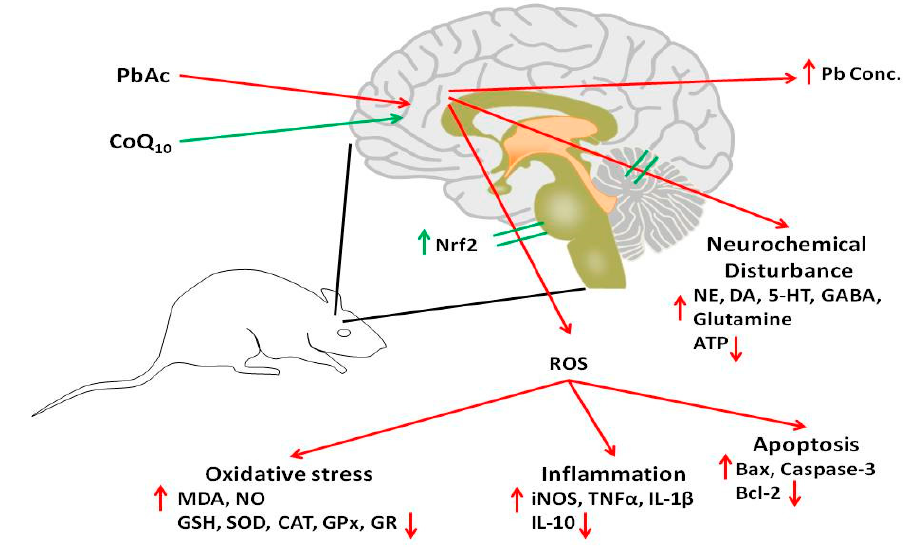
Figure 8. A summarized figure describes the potential protective role of CoQ10 against lead acetate-induced neurotoxicity; CoQ10: coenzyme Q10; PbAc: lead acetate; Nrf2: nuclear factor erythroid 2–related factor 2; ROS: reactive oxygen species; MDA: malondialdehyde; NO: nitric oxide;